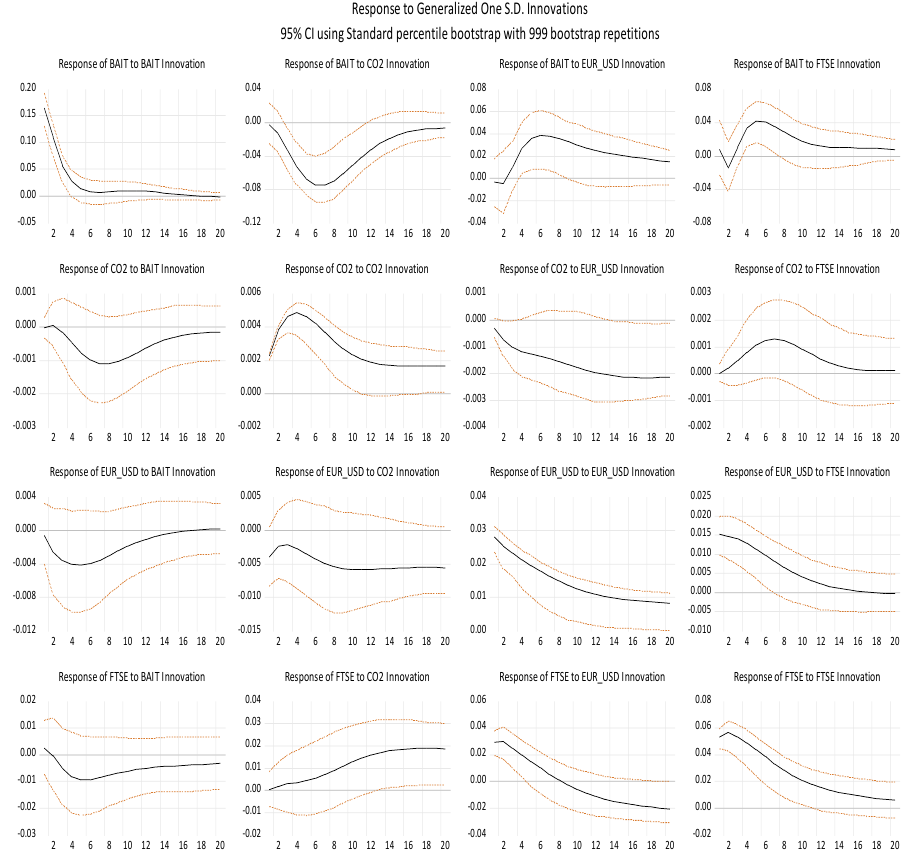
Figure 3. Impulse Response Analysis of the model variables for a twenty − period time horizon. As can be seen in all graphs, stability has been recovered after the tenth period.